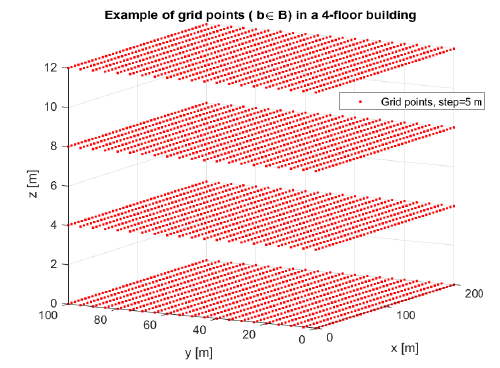
Figure 2. Example of mapping the whole building space B into grid points b , ∆ s = 5 m for a 100 × 200 m 2 building with 4 floors and 4 m floor height